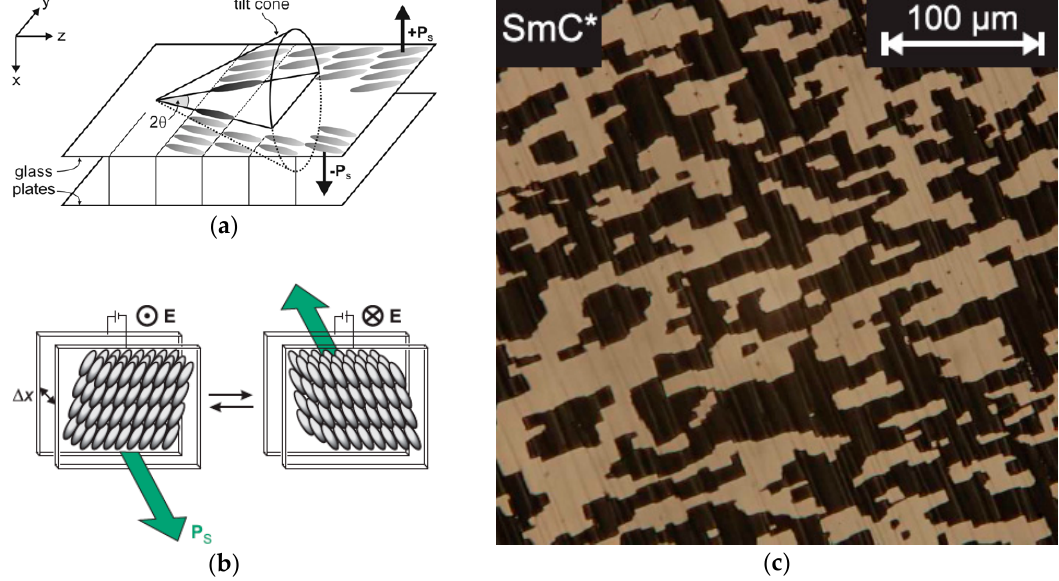
Figure 4. Surface stabilized ferroelectric liquid crystals (SSFLCs). ( a ) SmC* phase confined between two glass plates (with conductive indium tin oxide (ITO) electrodes) of a liquid crystal cell which aligns the SmC* director parallel to the glass surfaces. All possible tilt directions of the SmC* director are represented by the so-called tilt cone. Only the two tilt directions parallel to the glass surfaces meet the surface anchoring condition, and thus, the helical SmC* structure is suppressed if the gap between the glass plates is sufficiently small. The two possible tilt directions (±y) are coupled to opposite directions of the spontaneous polarization P s (up and down). ( b ) The application of an electric field E across the cell reorients the P s vectors of all domains into the direction of E . The field-induced reversal of P s also reverses the tilt direction of the SmC* director, which gives rise to a fast electro-optic effect if seen between crossed polarizers. ( c ) In the polarizing optical microscope, the ferroelectric domain structure of the virgin SSFLC configuration is seen between crossed polarizers as an array of bright and dark domains with opposite tilt directions, and thus opposite P s directions. (Reprinted with permission ( a ) from Springer Nature: [13], redrawn after [12]; ( b , c ) from A. Bogner: [14].)